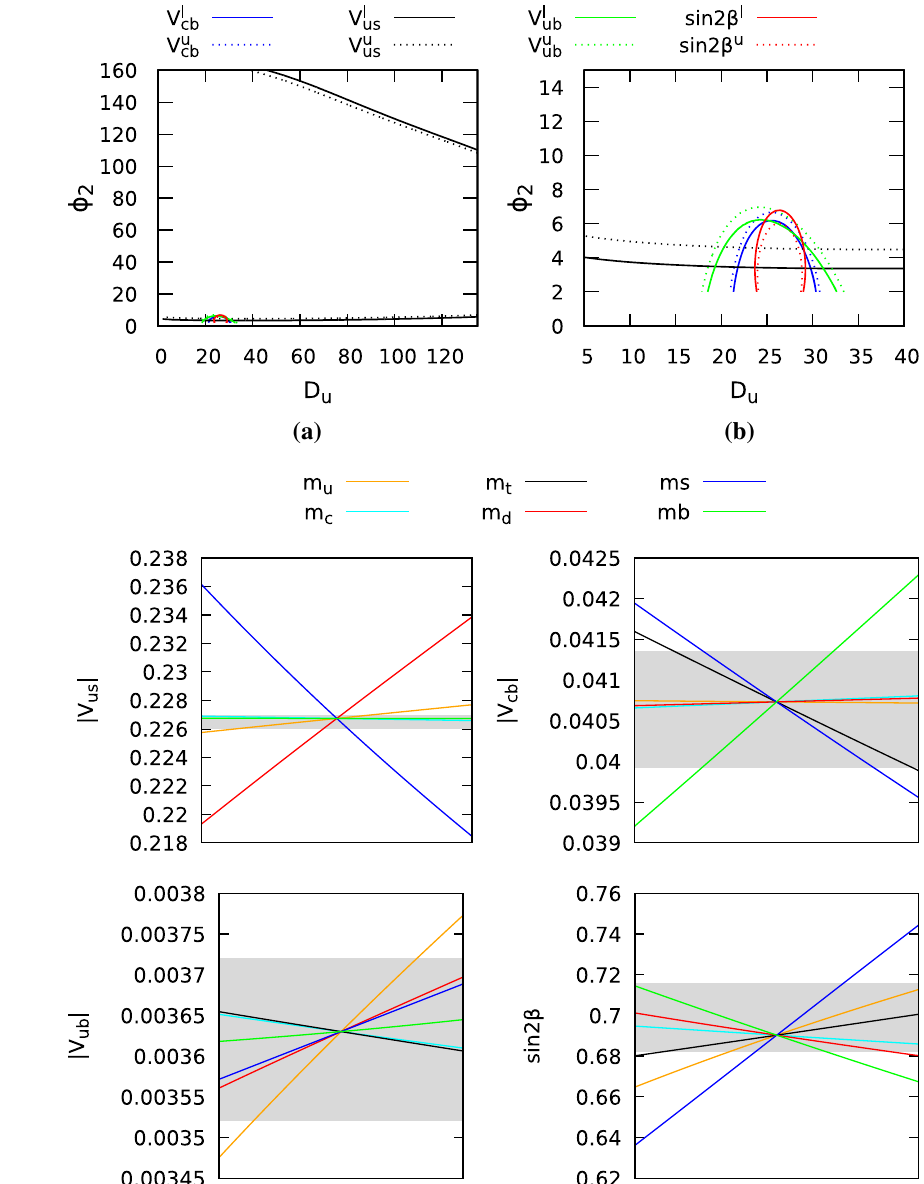
Fig. 5 Dependence of | V us | , | V | , | V | and β on quark ub cb masses m u (orange), m c (cyan), m t (black), m d (red), m s (blue), m b (green).The x-axis of each plot corresponds to the 1 σ variation in the quark masses, while the shaded region corresponds to the experimental value of that particular mixing parameter at 1 σ , as given in